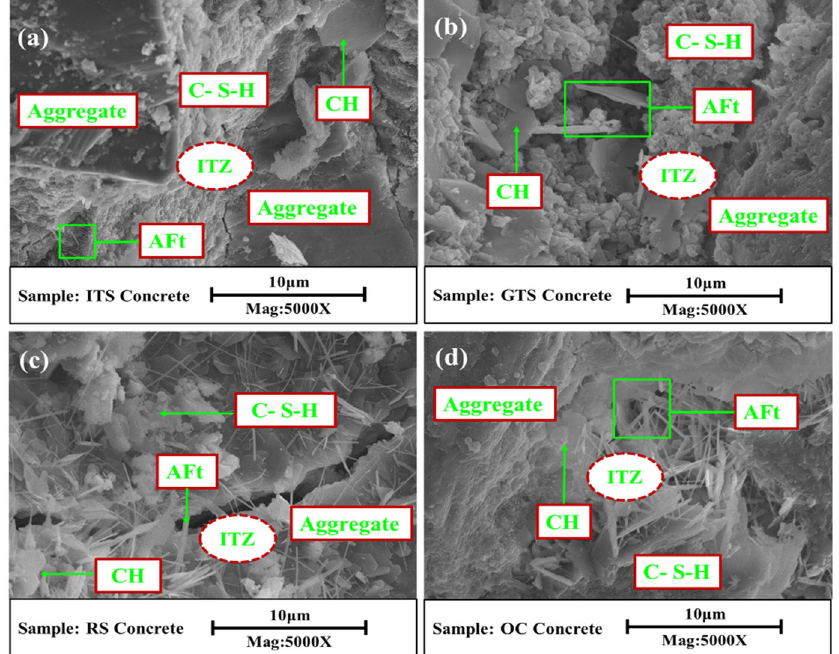
Figure 12. Hydration products of concrete ( a ) ITS sand concrete, ( b ) GTS sand concrete, ( c ) RS sand concrete, ( d ) Ordinary concrete.